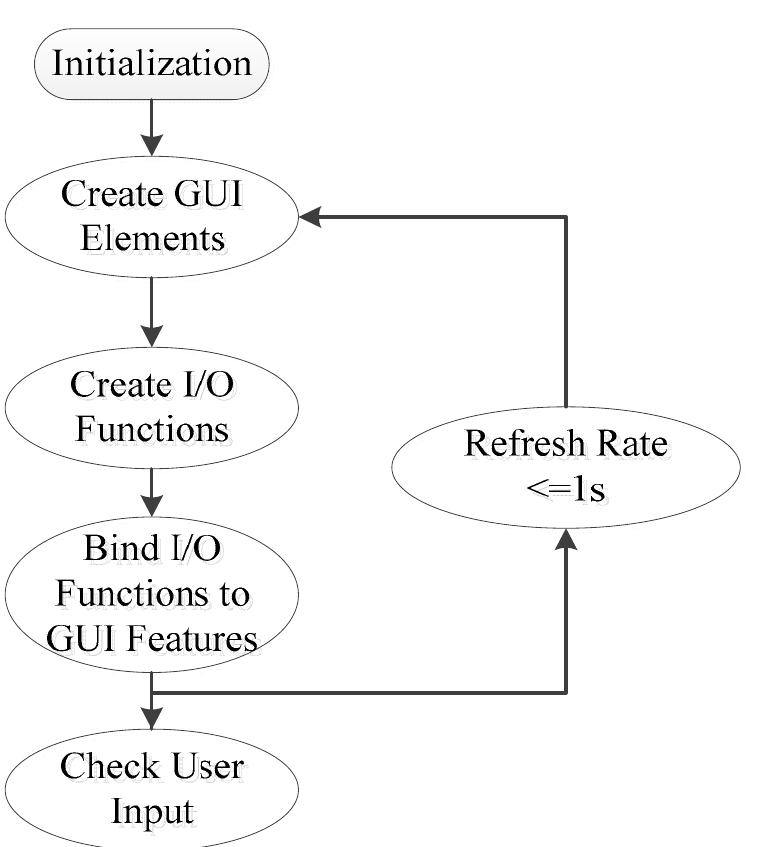
Figure 7. Flowchart for Graphical User Interface.